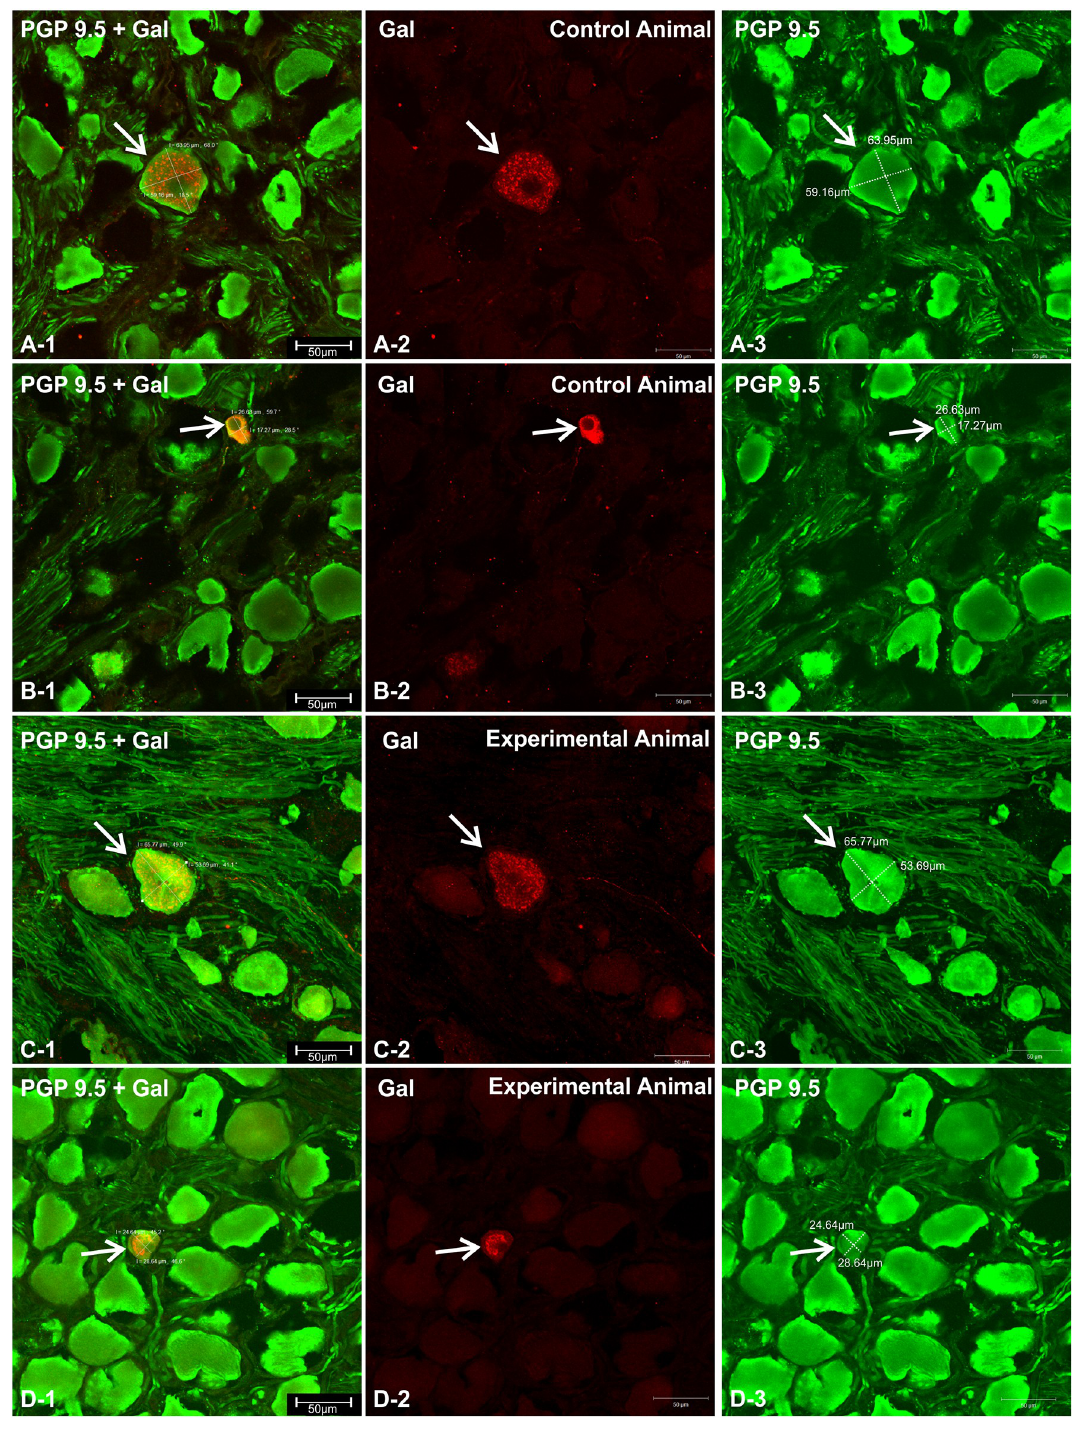
Fig 2. Distribution and typical characteristics (shapes, immunofluorescence) of PGP 9.5/Gal-immunofluorescent perikarya within the longitudinal cross-sectional plane of the nodose ganglion in the control and experimental animals. A set of microphotographs showing longitudinal cross-section of the representative inferior (nodose) vagal ganglion in the control ( A ) and experimental ( B ) animals, double immunostained with antibodies against PGP 9.5 (green channel) and galanin (red channel). The microphotographs present the overlap of both fluorescence channels. Figures ( A ) and ( B ) were created by combining a series of photomicrographs with the use of a confocal laser microscope tile scan function and present the entire cross-sectional surface of the